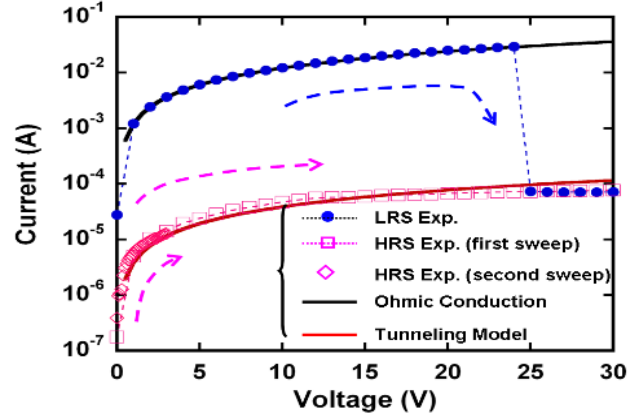
Figure 4. Current–voltage (I–V) characteristics of the NT resistive switching memory from the low-resistance state (LRS) to the high-resistance state (HRS). The I–V fitting lines of the LRS and the HRS are also calculated to understand the possible mechanisms. The blue and pink arrows indicate the sweeping voltage directions of the LRS and the HRS, respectively.